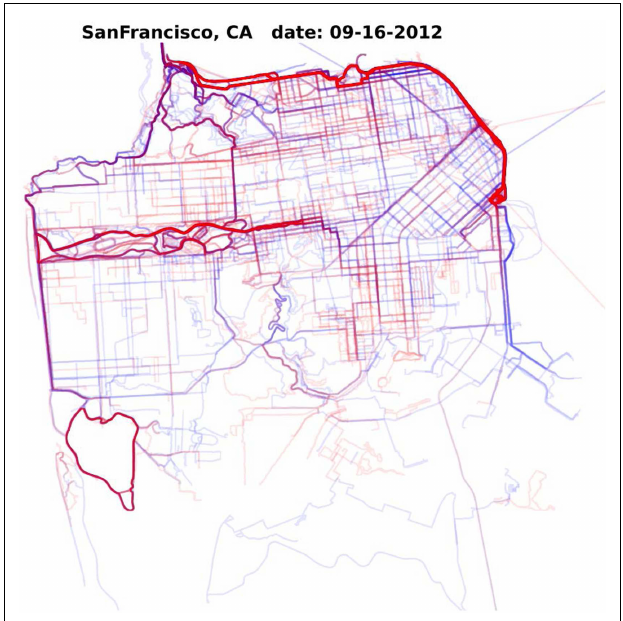
FIGURE 2 | Density of MapMyFitness routes in San Francisco, CA, USA on September 16, 2012 by sex . Blue represents routes by male MapMyFitness users, red represents routes by female MapMyFitness users.Thicker lines indicate more